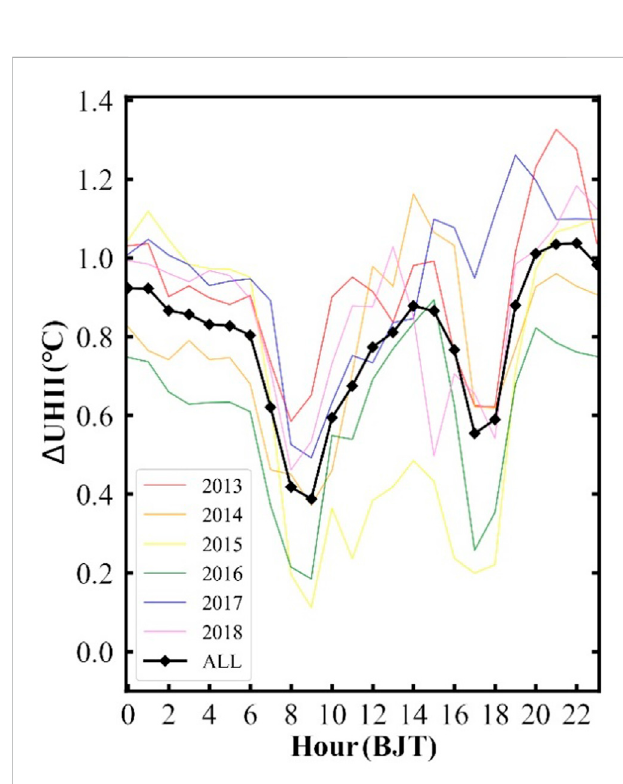
FIGURE 5 Diurnal variation in UHII difference ( Δ UHII) between HW and NHW periods in Guangzhou during 2013 – 2018 (BJT: Beijing